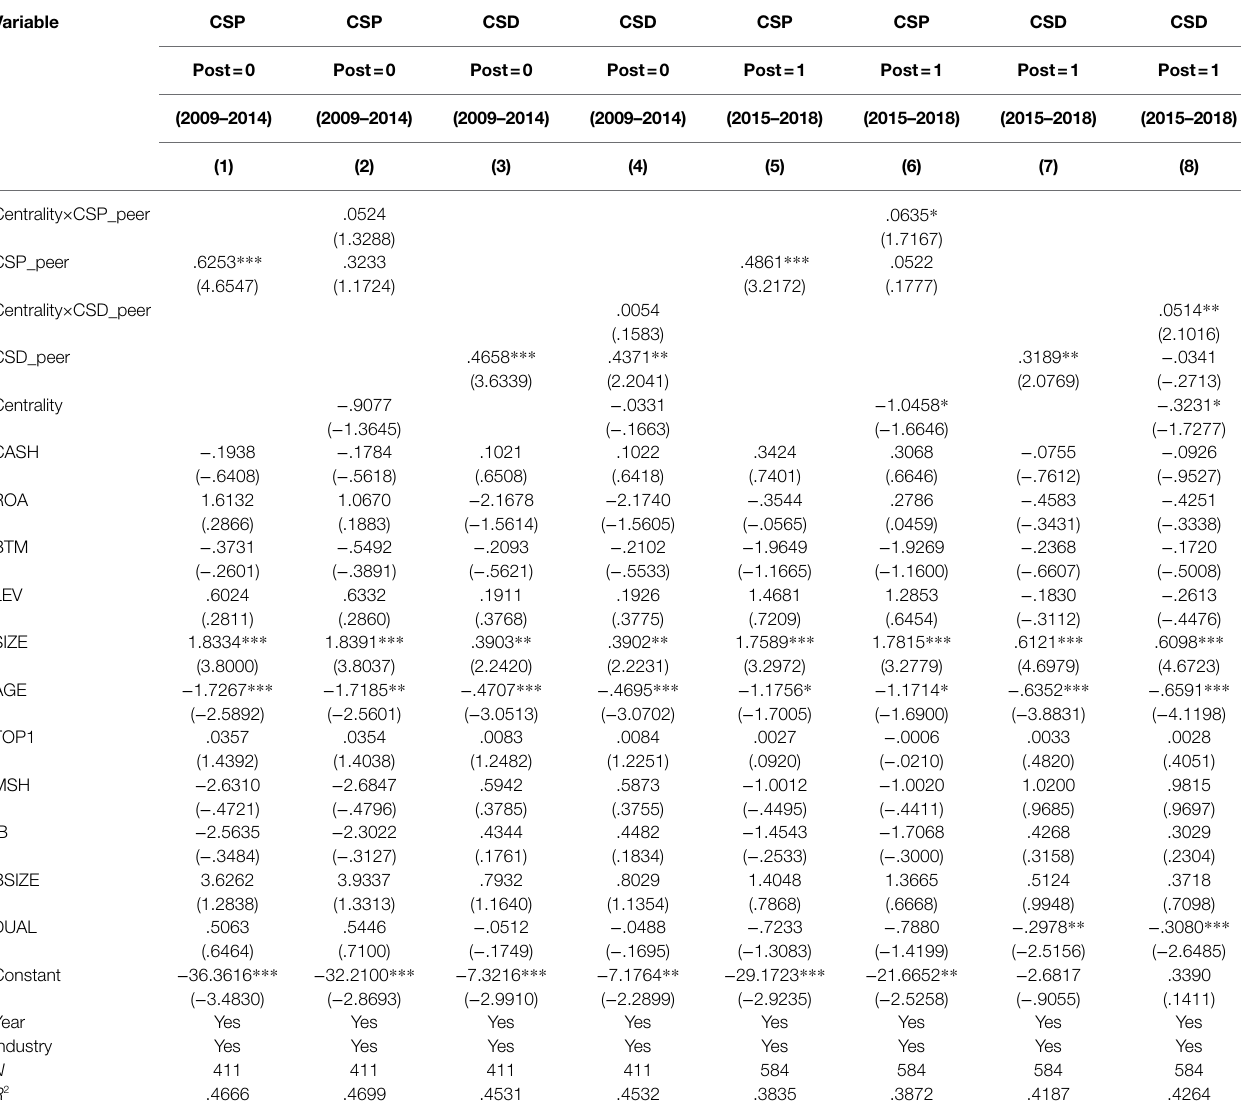
TABLE 9 | Heterogeneity test of peer CSR